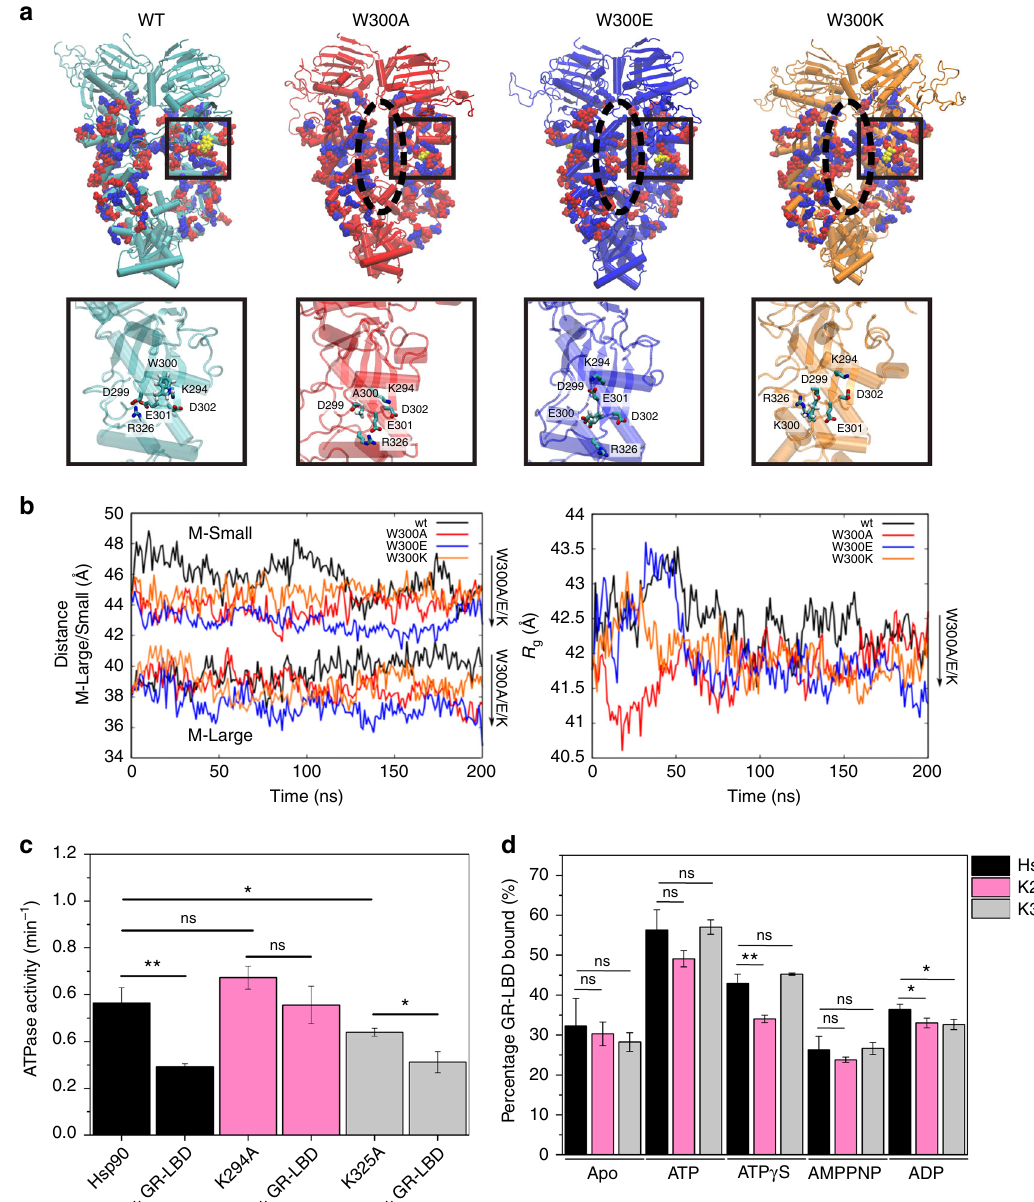
Fig. 5 Molecular dynamics simulations of the Hsp90 W300 mutants. a Global structures of the wt and W300A, W300E, W300K mutants of Hsp90, obtained from 200 ns MD simulations of each model. Charged residues in Hsp90-M are shown in van der Waals representation with negative residues in red, and positive residues in blue. In comparison to wt Hsp90, the mutants have more closed M-domains formed by inter-domain contacts (dotted lines). Inset: central residue interactions near W300: W300 forms transient cation – π interactions with K294, whereas replacements to A/E/K leads to increased repulsion/attraction between charge residues that induce conformational changes in surrounding loops and helices (see text). b Distance between the center of mass of two M-Large (res 264 – 426) domains and two M-Small (res 427 – 526) domains during the MD trajectories (left), and calculated radius of gyration R g (right) showing that the W300 mutations lead to a more compact Hsp90. c Absolute ATPase activities of Hsp90 K294A and K325A in the absence and presence of the GR – LBD. ATPase activity for wt Hsp90 is shown in black, for K294A in pink and for K325A in light gray. Shown are mean ATPase activities of three independent measurements including the standard deviation represented as black bars ( n = 3). Statistical signi fi cance was assessed using a two-sample t -test and a level of signi fi cance of 0.05. d AUC-analysis of GR-LBD binding to Hsp90 K294A and K325A in different nucleotide states; bars indicate mean amount of labeled GR – LBD found in the Hsp90/mutant complex in the presence of Hsp90 and indicated nucleotides. Measurements were performed in triplicates to rule out experimental fl uctuations ( n = 3). Error bars represent standard deviations from three independent measurements. Statistical signi fi cance was assessed using a two-sample t -test and a level of signi fi cance of